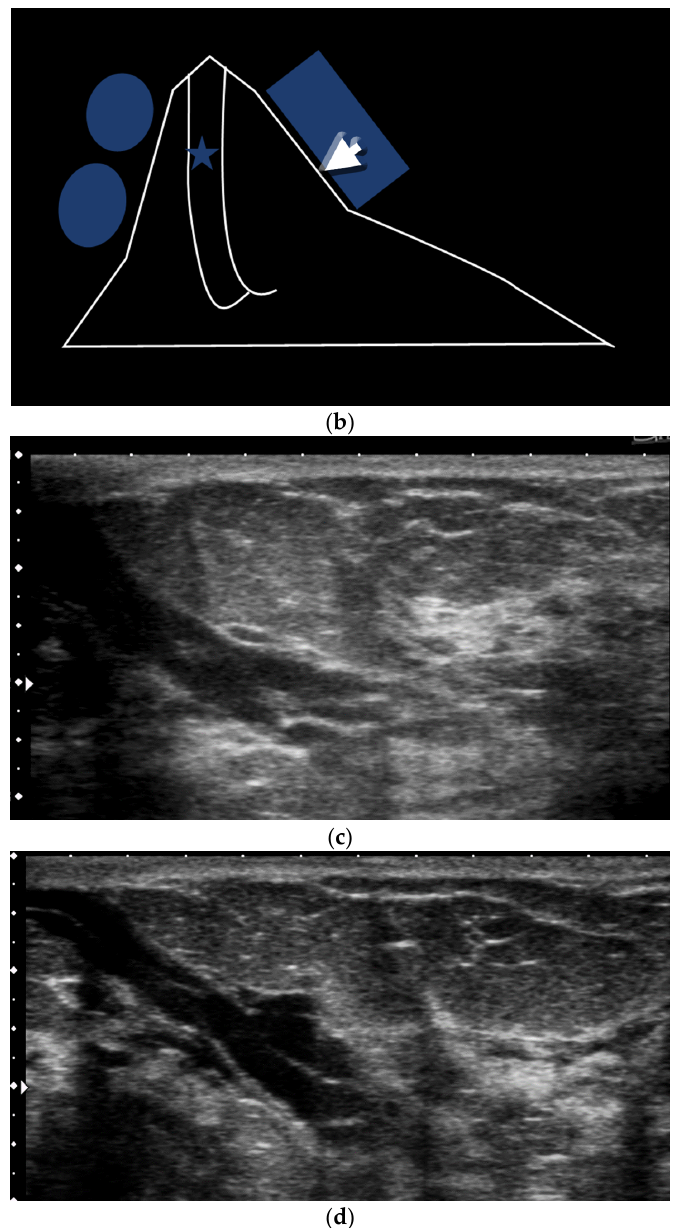
Figure 11. Two-handed compression technique compresses the retroareolar duct between the non-scanning hand and the probe. Photograph of the manoeuver ( a ) and its corresponding drawing ( b ). US pre manoeuver ( c ) and post manoeuver ( d ) images.